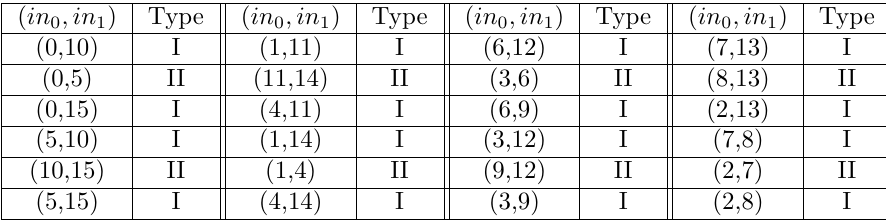
Table 3: All Possible Combinations of Active